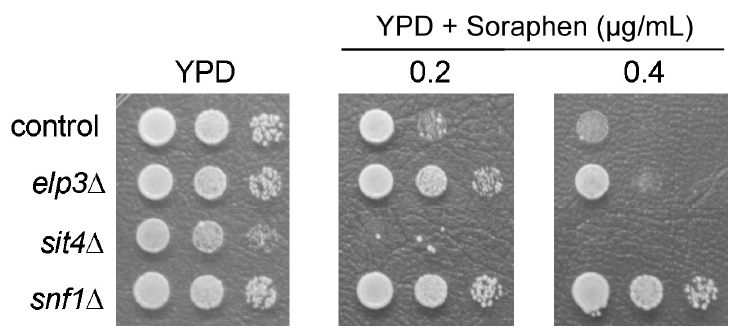
Figure 2. Soraphen A phenotype of elp3 mutants. Saccharomyces cerevisiae strains BY4741 (control) and its isogenic elp3 , sit4 and snf1 mutants were grown to stationary phase and seeded at a concentration of 10 7 , 10 6 or 10 5 cells/mL (from left to right) onto YPD medium plates containing the indicated soraphen A doses. Growth was recorded after three days. A representative result of three independent experiments is shown.